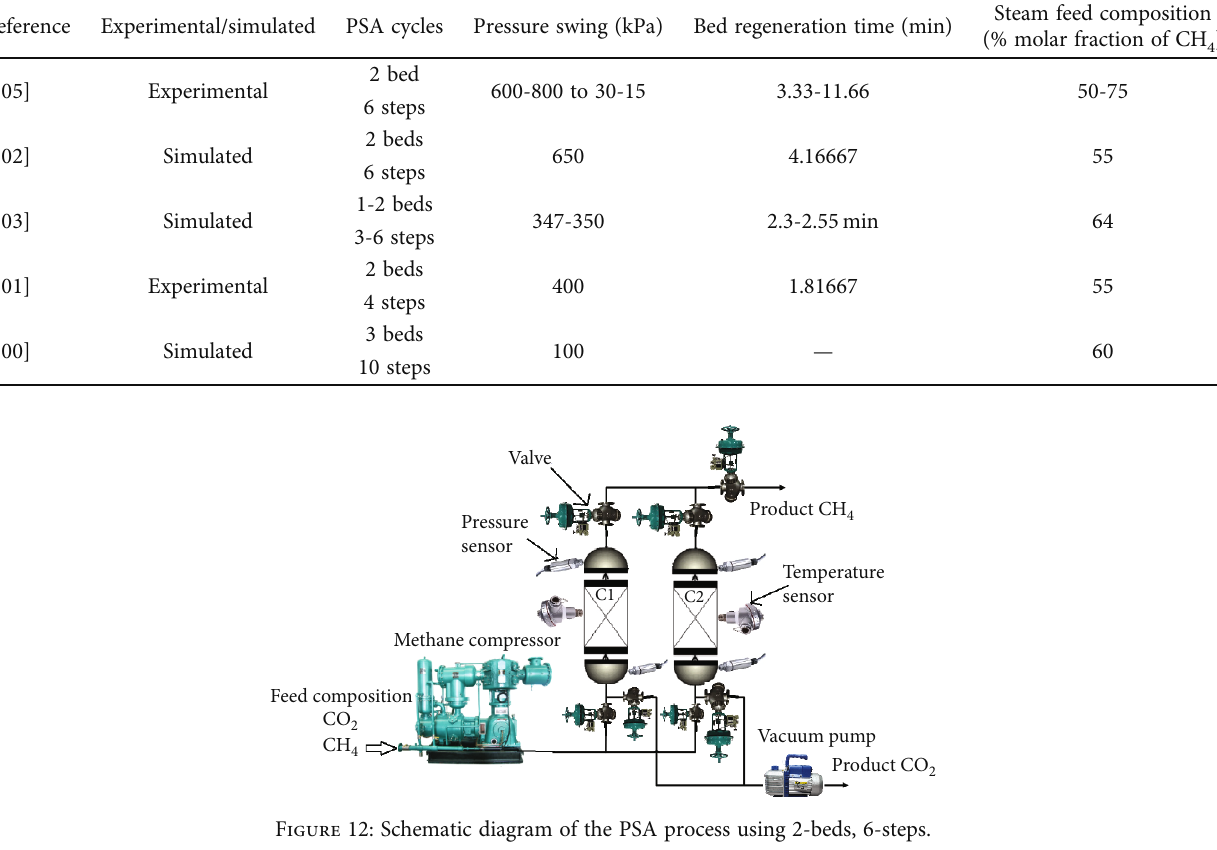
Table 21: Works reported on the di ff erent con fi gurations of PSA processes for puri fi cation of biomethane.